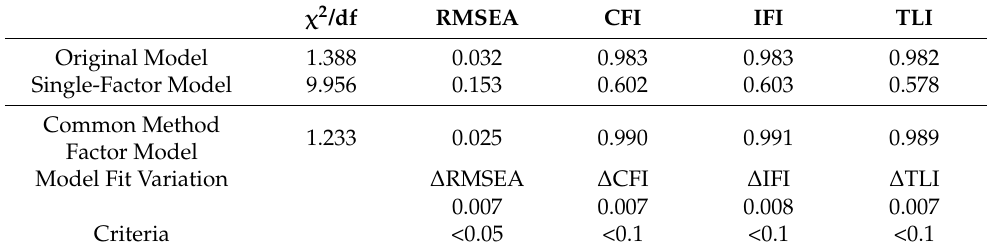
Table 2. Common Method Bias